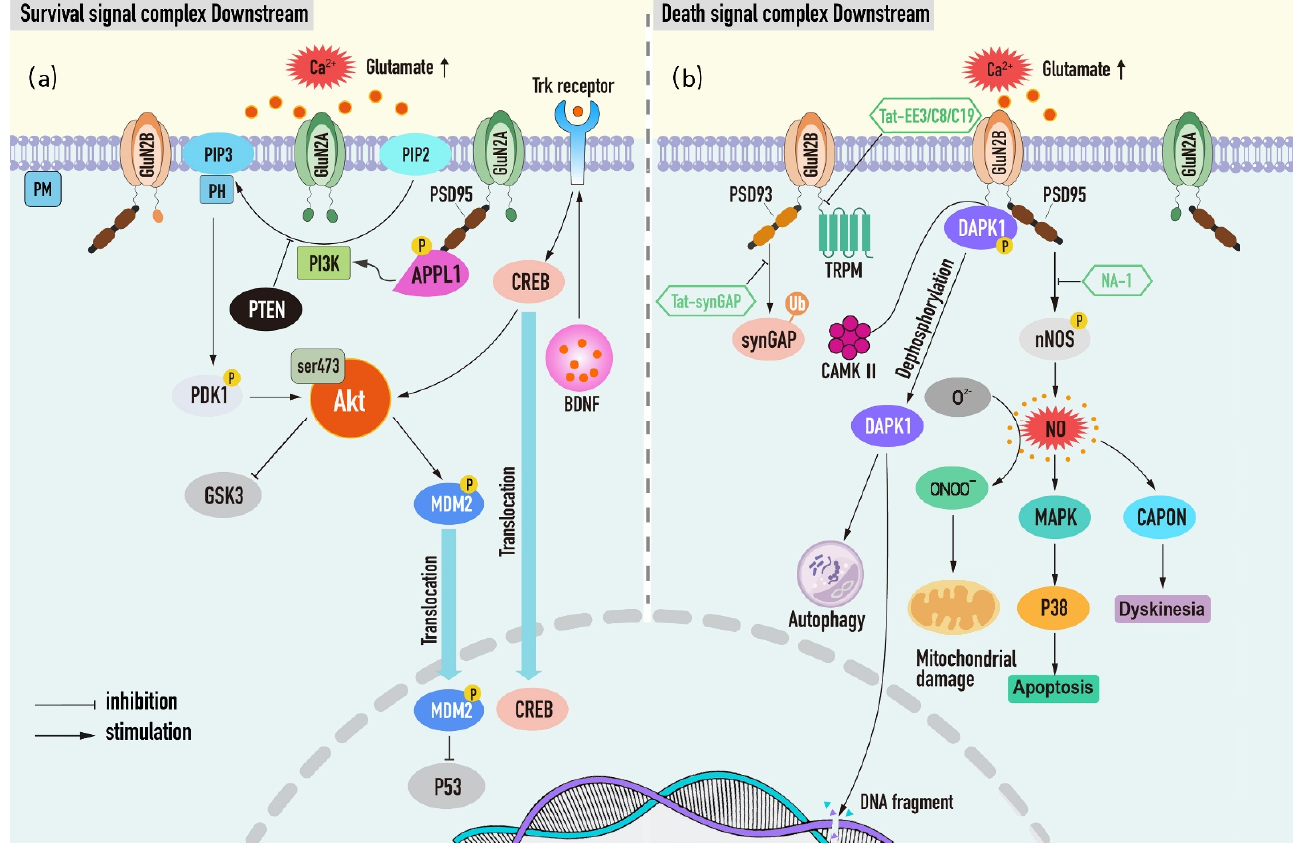
Figure 3. Neuronal survival and death signal complexes and downstream pathways associated with NMDARs. ( a ) Post-synaptic activity promotes neuronal survival via increasing the activation of the GluN2A-mediated PI3K/Akt complex and the downstream pathway. In addition, BDNF and PTEN are prosurvival and negative regulation factors, respectively, operating downstream of the PI3K/Akt, thereby producing opposite effects. ( b ) During cerebral ischemia, the influx of calcium through GluN2B-containing NMDARs induces phosphorylation of DAPK1 and formats PSD95- GluN2B-nNOS complex contributing to massive NO production and activating their downstream targets. Moreover, the GluN2B-PSD93-SynGAP and GluN2B-TRPM complexes are activated by hy- perfunctioning NMDARs leading to neuronal death. Some treatments have been developed to in- terfere with these death effects (depicted in